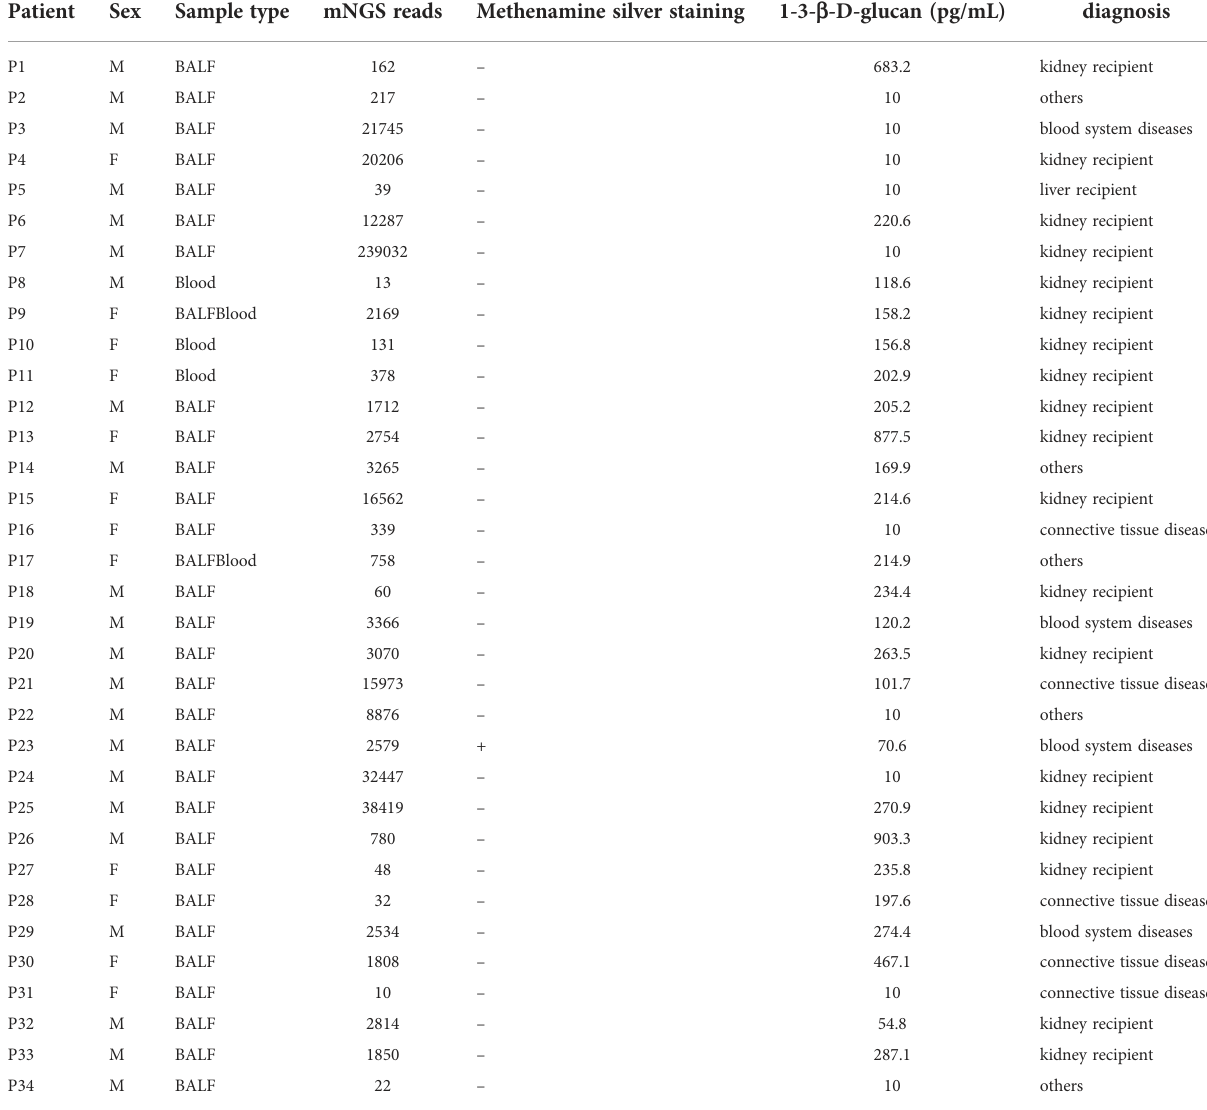
TABLE 1 Clinical microbiology results, sequencing information and demographic information of P. jirovecii positive patients.